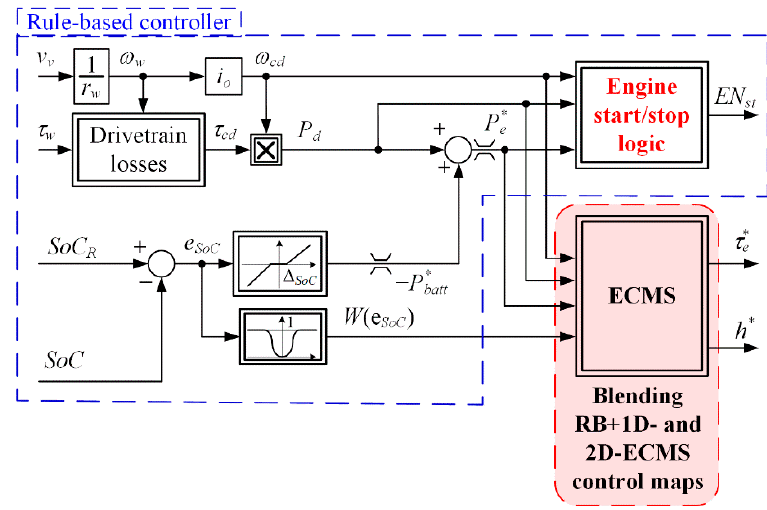
Figure 12. Block diagram map-based RB+ECMS control strategy.